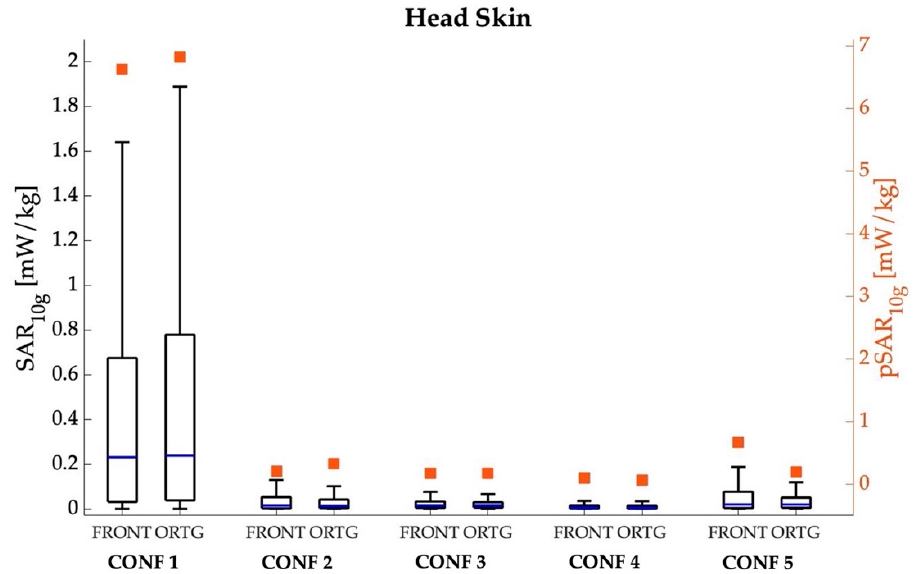
Figure 5. SAR 10g (left y -axis, box plot) and pSAR 10g (right y -axis, square symbols) in the skin tissue over the whole body for the five different examined configurations, considering the frontal and orthogonal orientations of the Ella model. The center line in the boxes is the median; the bottom and top edges are the 25th and 75th percentiles. The lower whisker extends to the minimum value, while the upper whisker extends to 1.5 times the height of the box.